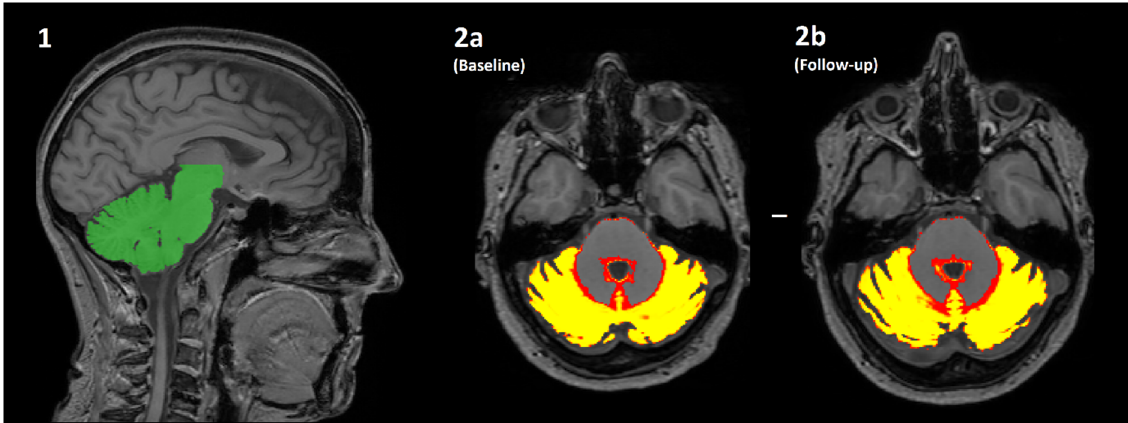
Figure 1. An overview of how the volume of cerebellar grey matter is estimated using the SUIT pipeline. ( 1 ) The cerebellum is automatically identified (green) and segmented from the original T1-weighted image. ( 2a / 2b ) The cerebellum is then further segmented into a “tissue probability map”, where the value of each pixel is transformed into the % probability that it is brain grey matter. The mean of all pixels with a non-zero value is multiplied by the volume of all such pixels (i.e., the mean*volume of red/yellow regions) for both the baseline ( 2a ) and follow-up ( 2b ) scans. The difference in values is the estimated change in volume over time, which is further normalised by the actual length of time between scanning sessions to produce percentage yearly brain volume change